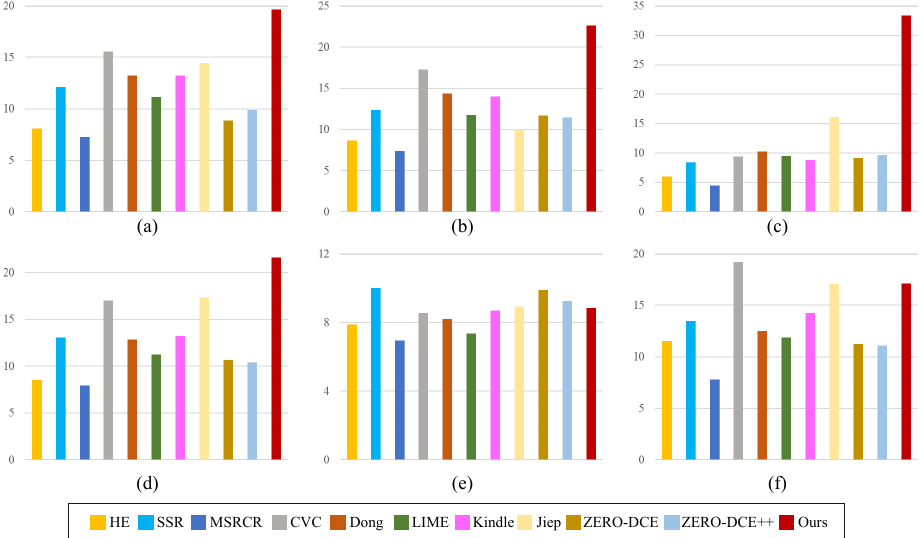
Figure 7. Quantitative comparisons in terms of PSNR. ( a ) LIME [28], ( b ) DICM [11], ( c ) LOL [14],